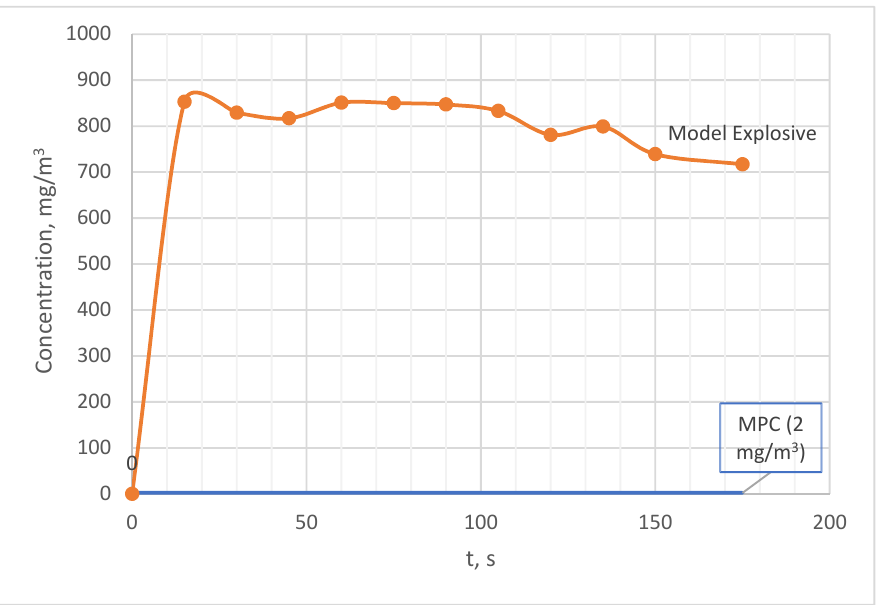
Figure 4. Dependence of the concentration of nitrogen oxides in the explosion products of a model explosive (compiled by the author R.S. Babkin).